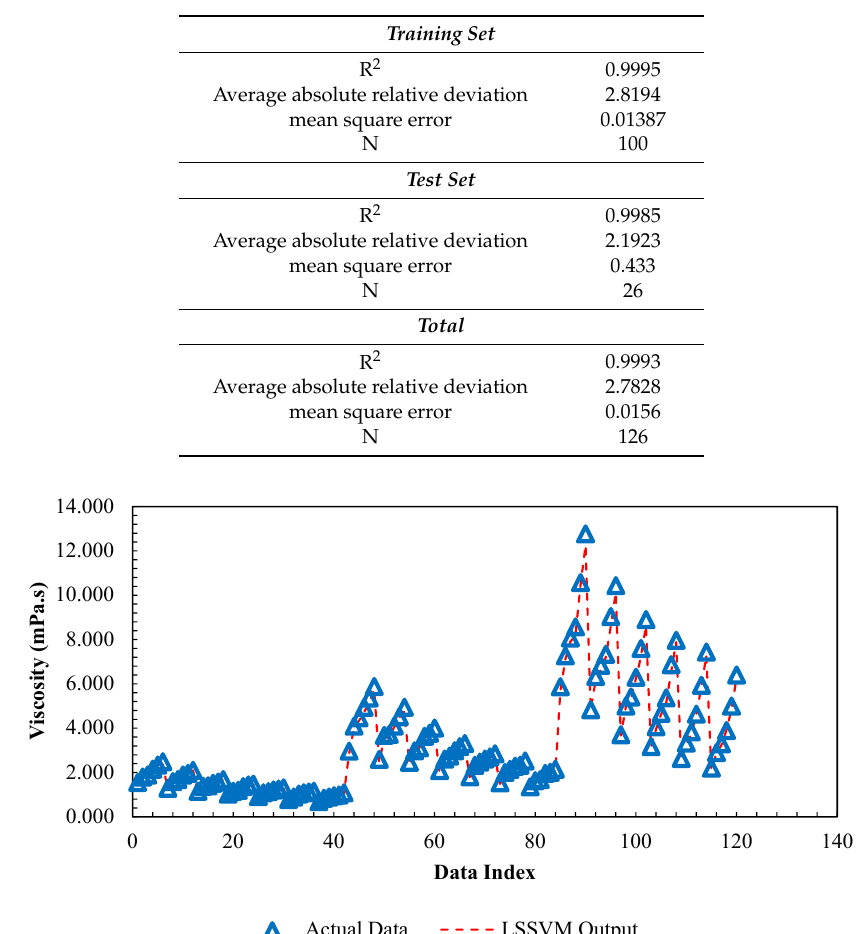
Figure 7. Comparison between actual viscosity of Fe 2 O 3 /ethylene glycol-water nanofluid and predicted values by Least Square Support Vector Machine (LSSVM) model versus relevant data index.